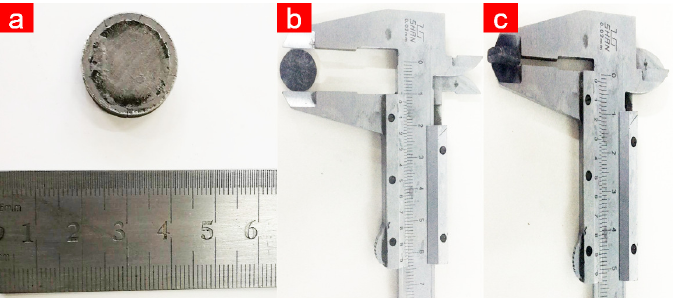
Figure 7. ( a ) Bi 2 Te 3 solid-state pellets; ( b ) The diameter of solid-state pellets; ( c ) The thickness of solid-state pellets.